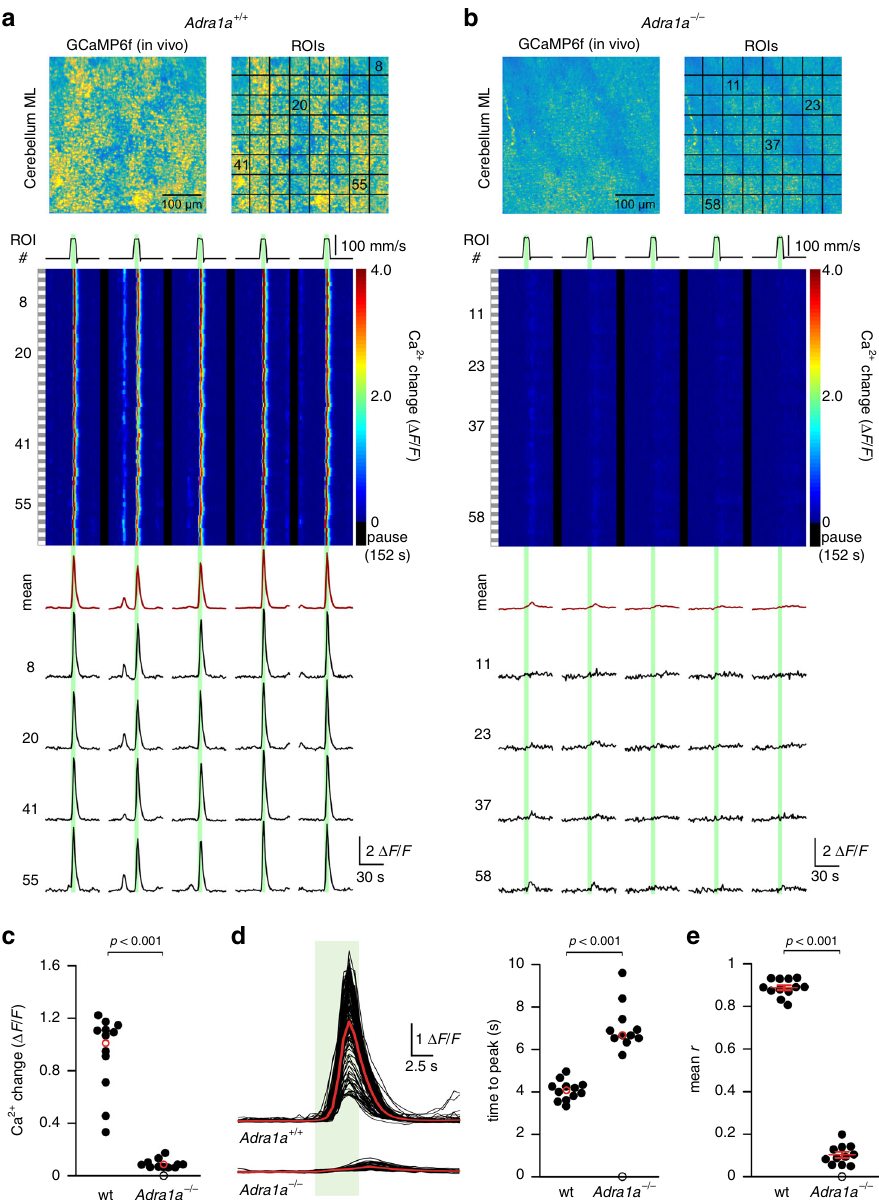
Fig. 3 α 1A -adrenergic receptor is required for vigilance-dependent BG Ca 2 + activation. a Upper, Pseudocoloured fl uorescence images of BG processes of Slc1a3-CreER T ;Ai95; Adra1a + / + mouse and ROI assignments (12 independent experimental repetitions with similar results). Middle, Pseudocolour plot of ROIs ’ Ca 2 + dynamics. Green bars, enforced locomotion. Lower, Average Ca 2 + response of all ROIs (dark red) and Ca 2 + response traces within number- de fi ned ROIs. b Same as a ; however, for Slc1a3-CreER T ;Ai95;Adra1a − / − mouse (11 independent experimental repetitions with similar results). c Population data: mean enforced locomotion-induced Ca 2 + activation (5 s before peak to 5 s after peak) of Adra1a + / + (wt) and Adra1a − / − mice. Red symbols indicate median. Empty circle indicates that one Adra1a − / − mouse had no detectable Ca 2 + response. n = 12 mice, respectively; Kruskal – Wallis test. d Left, Overlay of peak-aligned Adra1a + / + and Adra1a − / − fl uorescence traces. Green bar, enforced locomotion. Red traces represent median traces. Right, Population data: time from onset of locomotion to peak amplitude. Red symbol indicates median. n = 12 mice, respectively; Kruskal – Wallis test. e Population data: mean correlation coef fi cient ( r ) (10 s before peak to 10 s after peak); red symbols indicate mean ± SEM. n = 12 mice, respectively; t (21) = 43.717; unpaired, two- tailed Student ’ s t -test. Source data are provided as a Source Data fi